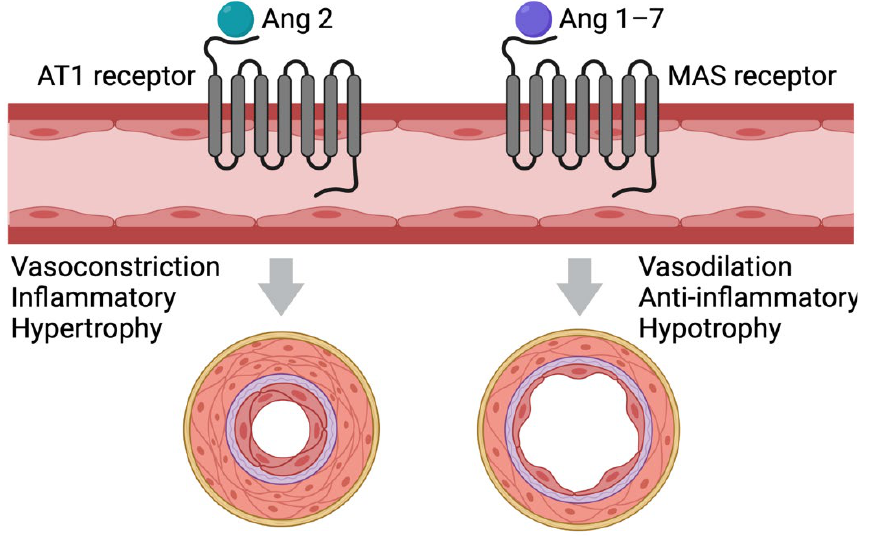
Figure 2. Effect of angiotensin 2 and angiotensin 1–7 on the vasculature. Angiotensin 2 binds to the G-protein coupled AT1-receptor, activating a downstream signaling pathway, leading to vasoconstriction, hypertropia, and inflammation of the blood vessels. Angiotensin 1–7 binds to the G-protein coupled MAS-receptor, which counter-regulates the effect of angiotensin 2. AT1: Angiotensin 2 Type 1; MAS: mitochondrial